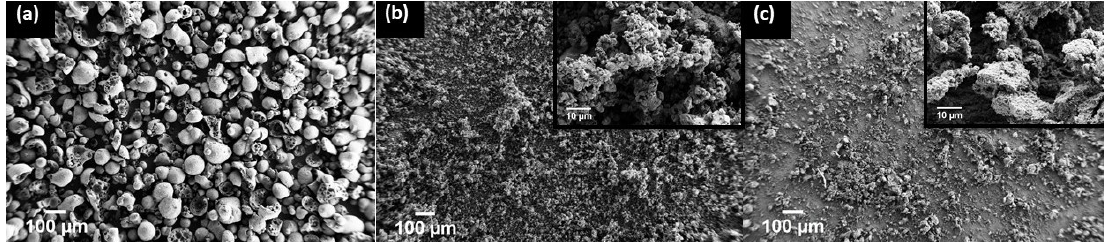
Figure 2. FE-SEM of ( a ) un-milled BioC, ( b ) milled BioC, and ( c ) CB shows that the size reduction of the BioC after milling is comparable to the particle size of the